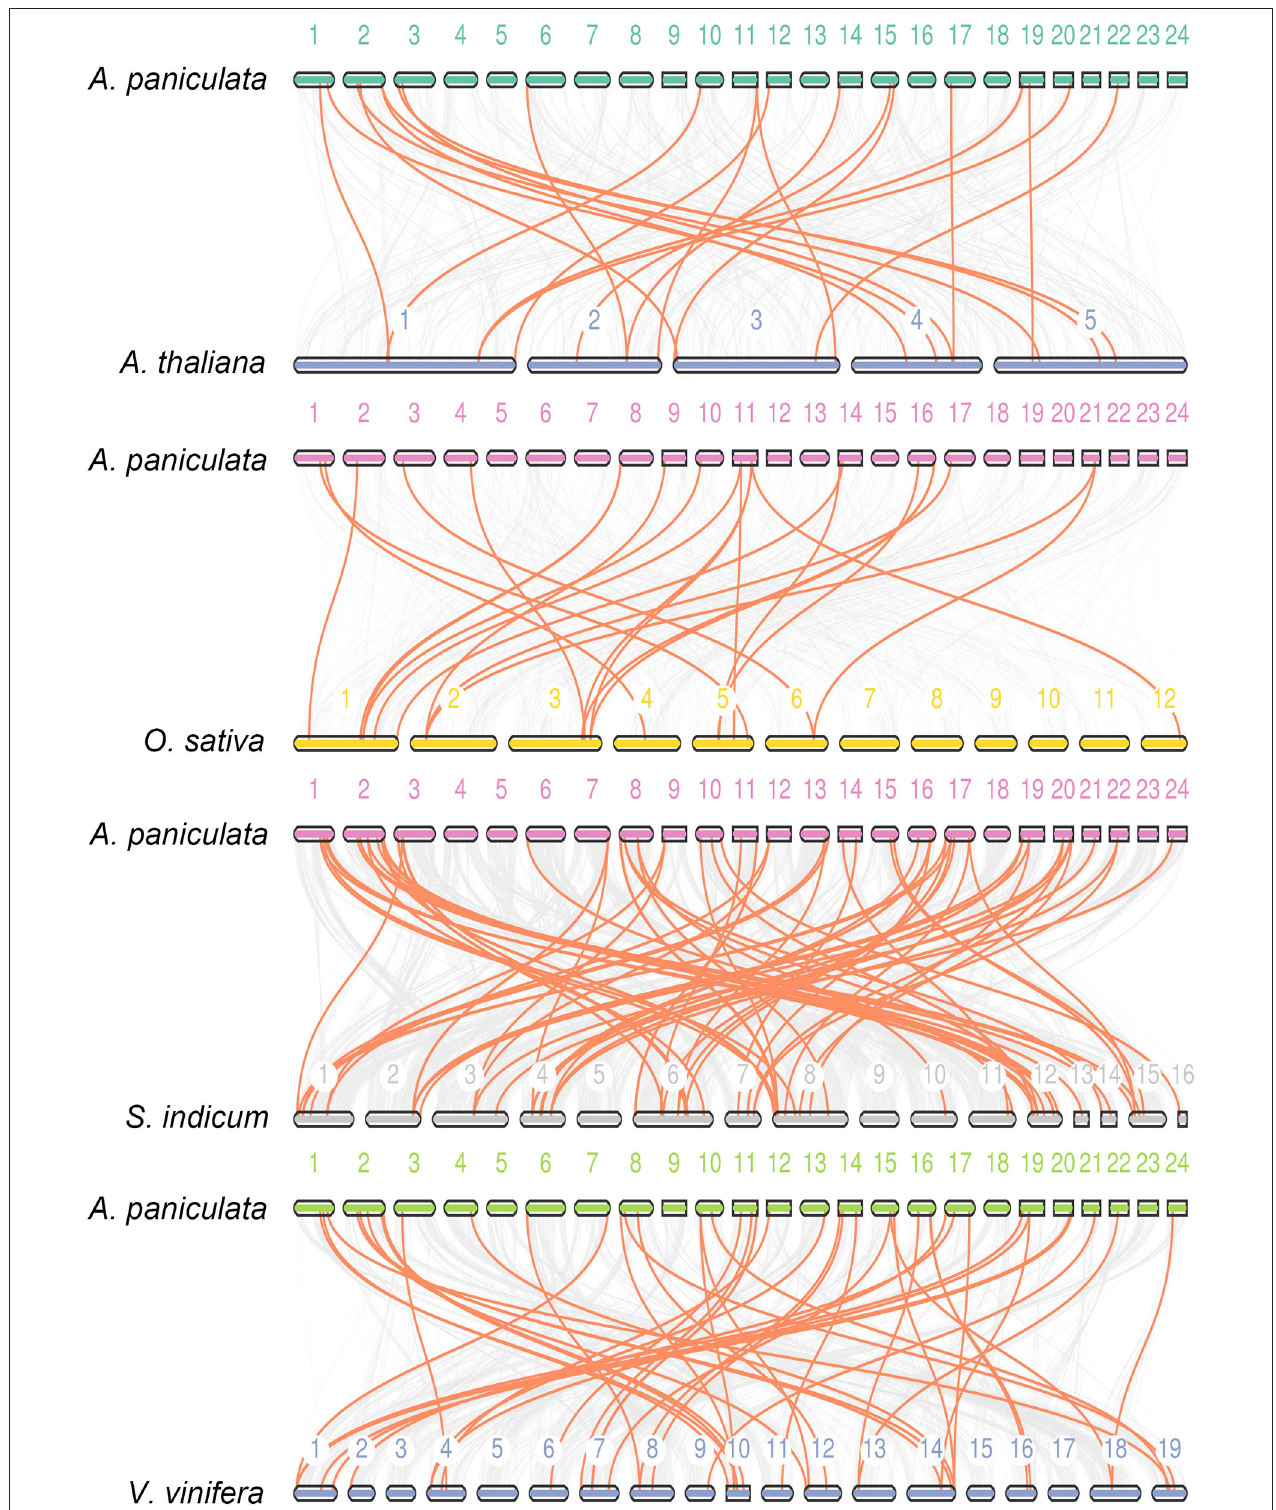
FIGURE 5 | Synteny analysis of WRKY genes. Synteny between A. paniculata and Arabidopsis , O. sativa , S. indicum and V. vinifera is shown. Colored lines denote syntenic regions between Chuanxinlian chromosomes and others.